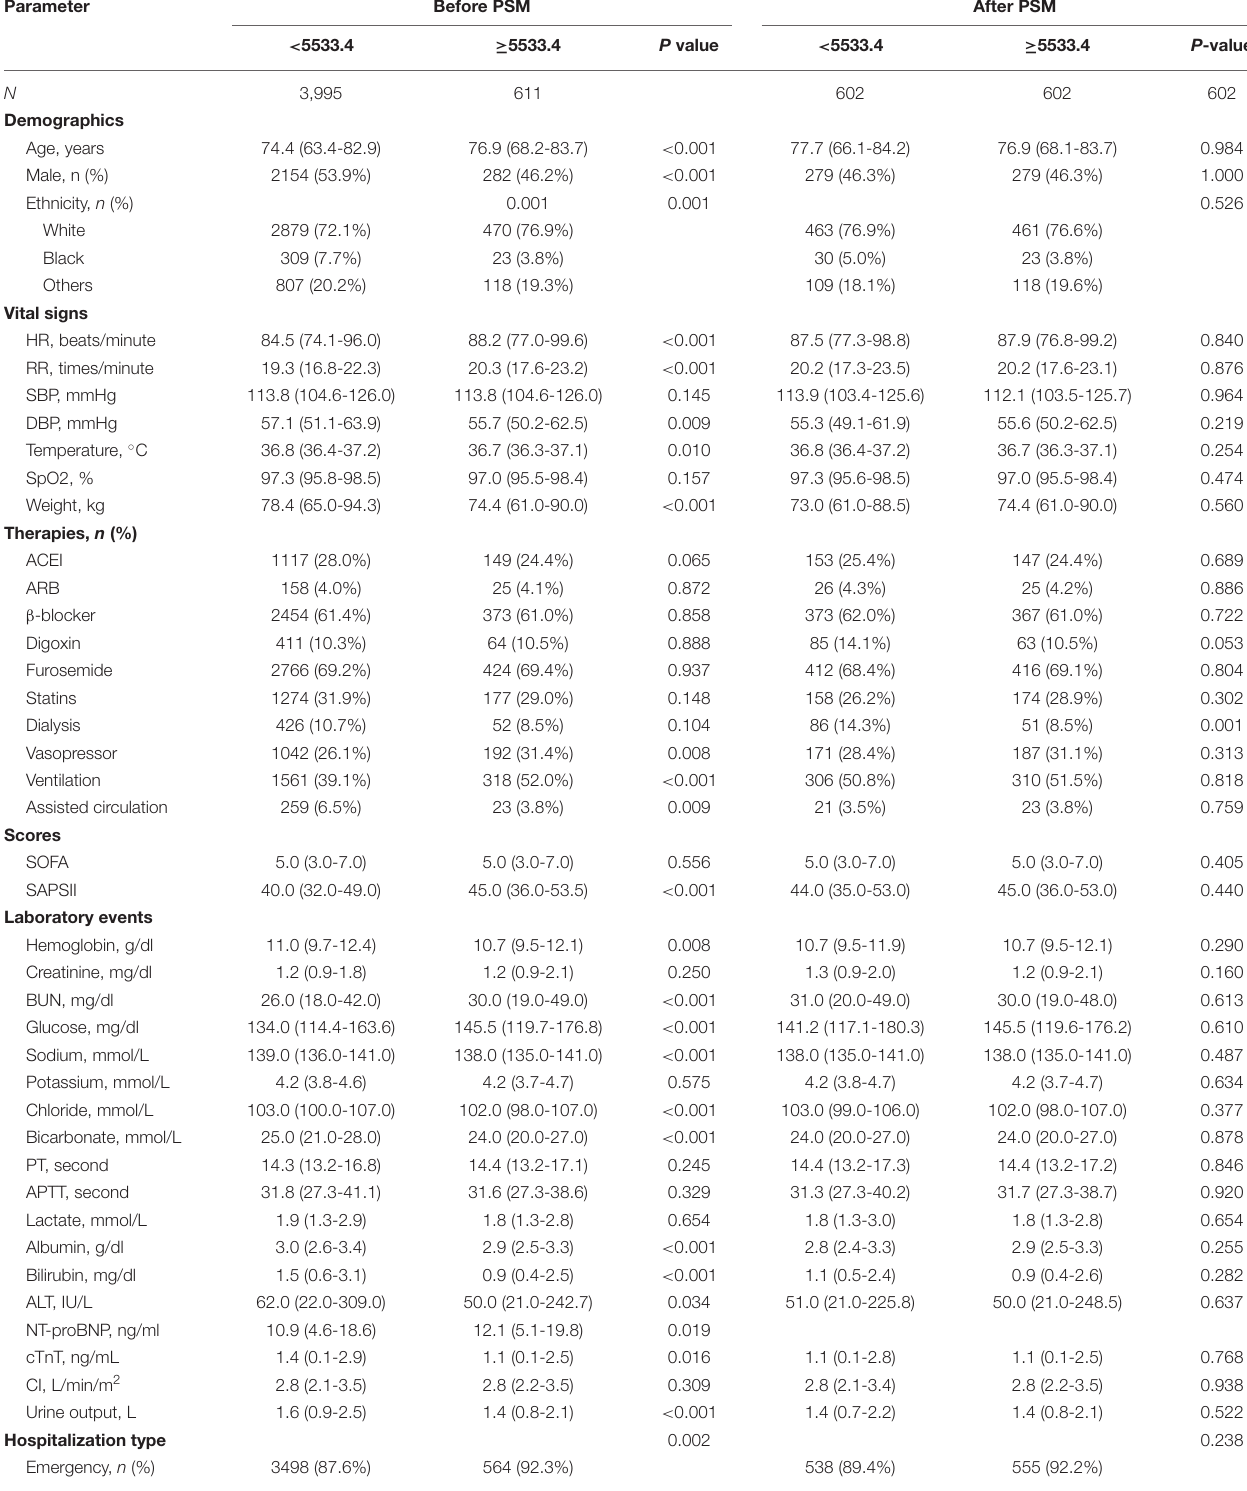
TABLE 5 | The clinical characteristics in critically ill patients with CHF before and after PSM. Parameter Before PSM After